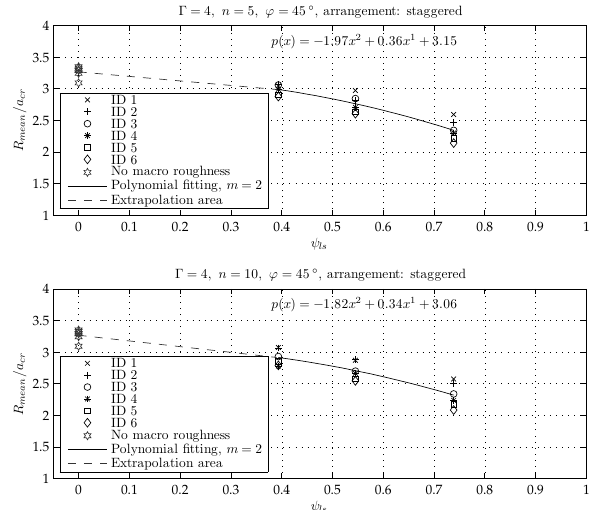
Fig. 11. The relative wave run-up ( R mean ) as a function of the long- shore obstruction ratio ( ψ ls ), 0 = 4. The experimental data are fit- ted to a polynomial of degree m = 2 and the equations are given according to the investigated number of MR rows n = 5 ,